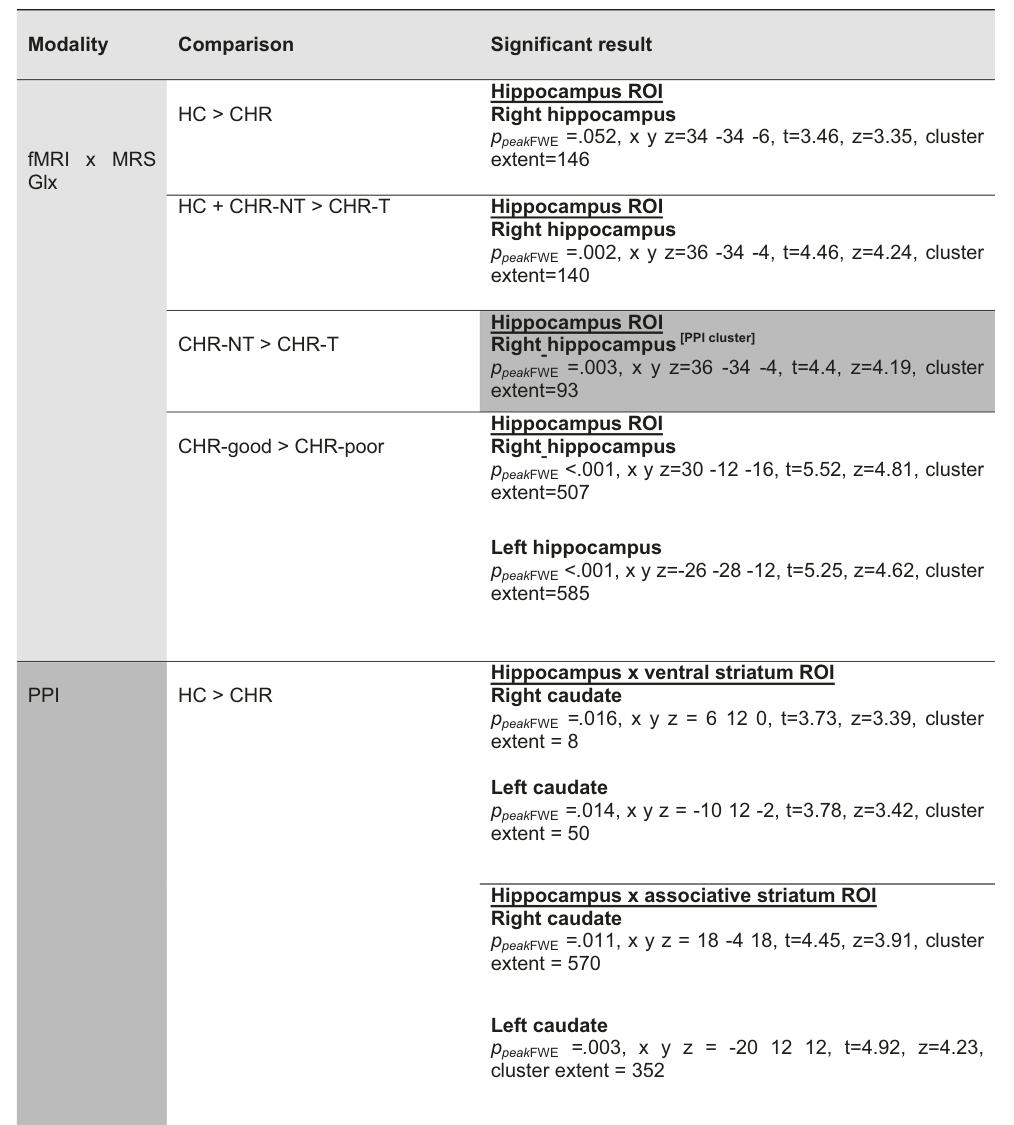
Table 2. Results split by modality, comparison and lateralisation with the cluster selected for PPI analysis